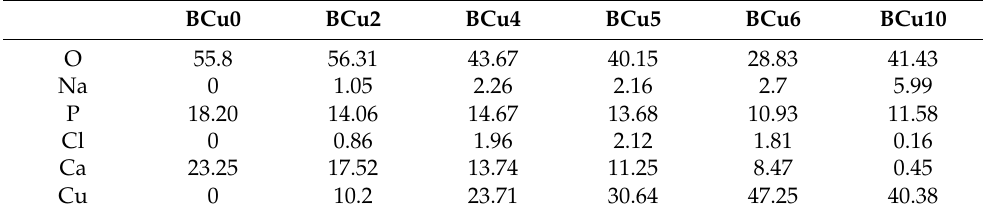
Table 4. Chemical composition of the Ca-Cu compounds in atomic% based on the EDX